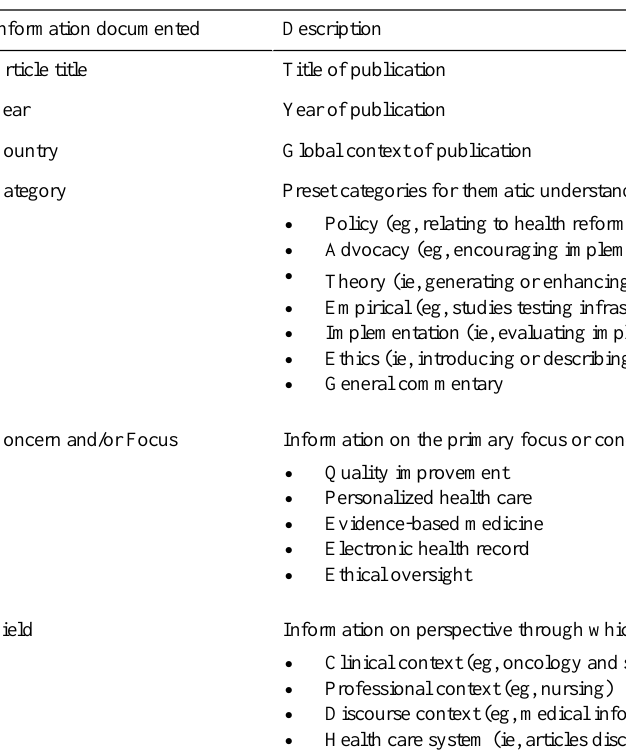
Table 1. Summary of abstracted